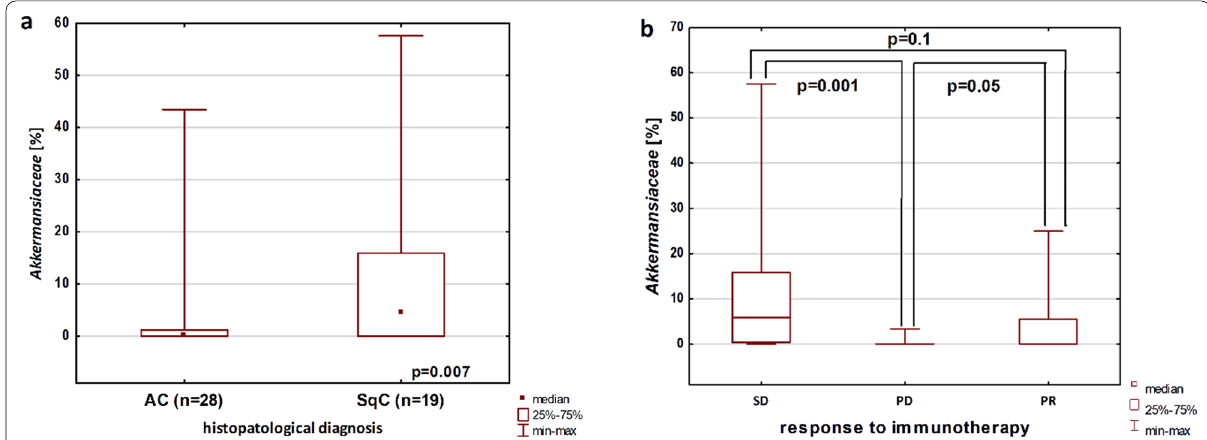
Fig. 1 Differences in the percentage of Akkermansiaceae among other bacterial families determined by the NGS method: a in different histopathological subtypes of NSCLC, b in groups of patients with different responses to